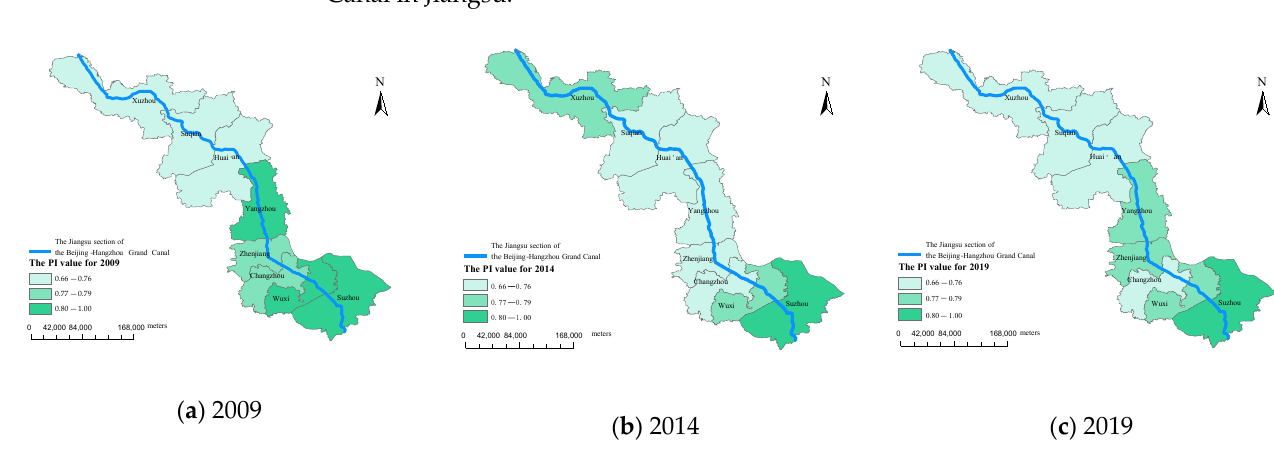
Figure 5. Analysis of green city evaluation results.